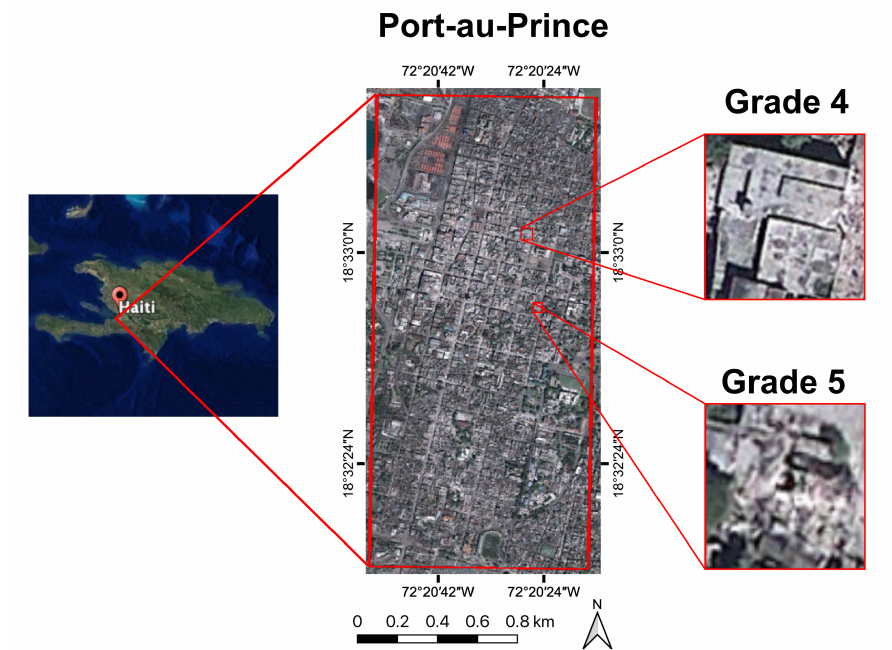
Figure 8. Location of the acquired dataset used for the generalization test.